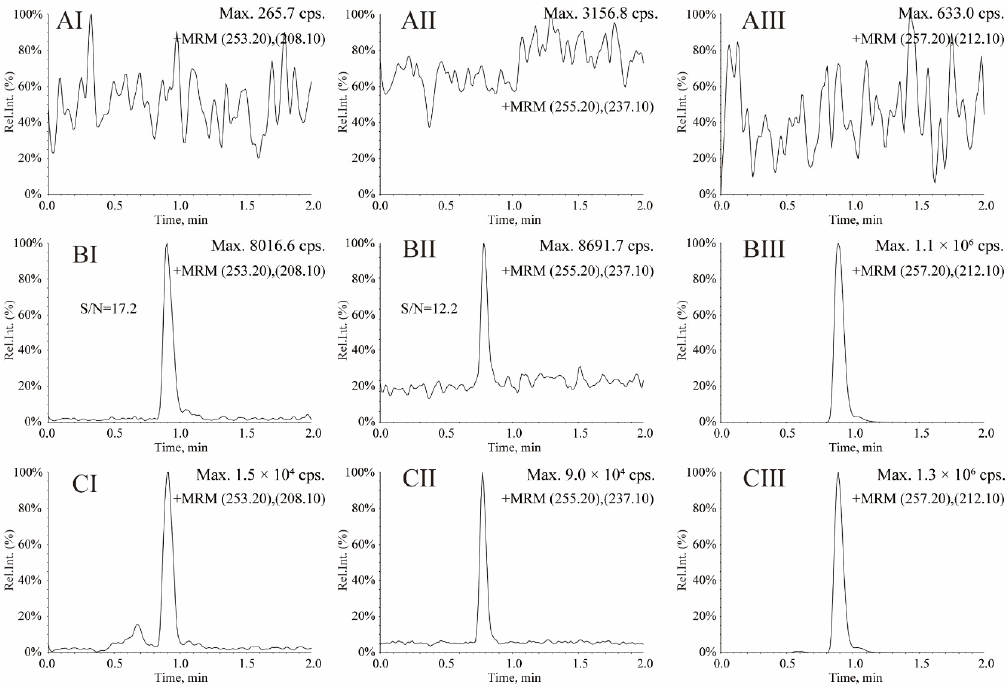
Figure 4. Representative LC-MRM chromatograms for oxcarbazepine ( I ), 10-hydroxycarbazepine ( II ) and oxcarbazepine-d 4 ( III ). ( A ) Blank human serum; ( B ) blank human serum spiked with oxcarbazepine at 25 ng/mL of LLOQ ( BI ), 10-hydroxycarbazepine at 0.5 µg/mL of LLOQ ( BII ) and 5.0 µg/mL of IS ( BIII ); ( C ) a serum sample from a patient with epilepsy after oral administration of oxcarbazepine.